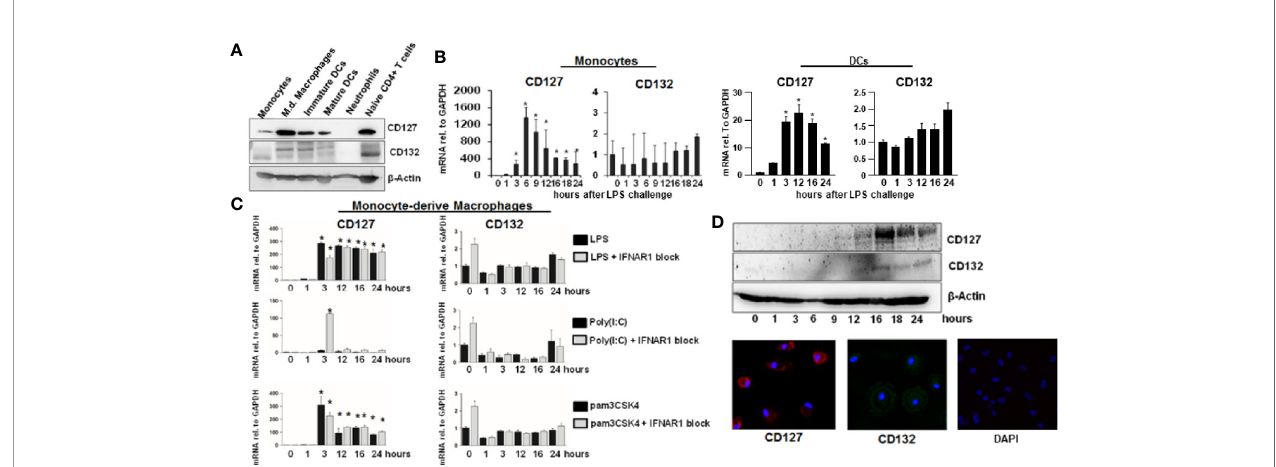
FIGURE 4 | Inducible expression of CD127 in monocyte-derived macrophages. (A) S elected immune cells from the innate and adaptive immune system were isolated from Buffy Coats from healthy donors. Some cell types (Neutrophils, CD14 + monocytes, and naive CD4 + T cells were lysed directly after the isolation. Some CD14 + monocytes were matured into Monocyte-derived macrophages, immature and mature DCs as described in the methods section. The amount of CD127 and CD132 was analyzed via Western Blot with b -Actin as reference. One out of two experiments (n=2) is shown as demonstration. (B) mRNA levels of CD127 and CD132 relative to housekeeping GAPDH mRNA in freshly isolated monocytes and DCs, which were stimulated with 10 ng/ml lipopolysaccharide (LPS) for the displayed time points. Standard deviations of two experiments (n=2) performed with three replicates each are shown. * P < 0.05 for comparison of the indicated time points with baseline. (C) mRNA levels of CD127 and CD132 relative to housekeeping GAPDH mRNA in monocyte-derived macrophages, which were stimulated with 10 ng/ml LPS, 100 ng/ml poly(I:C) HMW or 100 ng/ml pams3CSK4, with or without 5 µg/ml antibody against IFNAR1, for the time points shown. Standard deviations of three experiments (n=3) performed with three replicates each are shown. * P < 0.05 for comparison of the indicated time points with baseline. (D) Monocyte-derived macrophages were stimulated with 10 ng/ml LPS for the displayed time points. The amount of CD127 and CD132 was assessed by Western Blot (top panel) and by immuno fl uorescence (bottom panel). One out of two experiments (n=2) is shown as